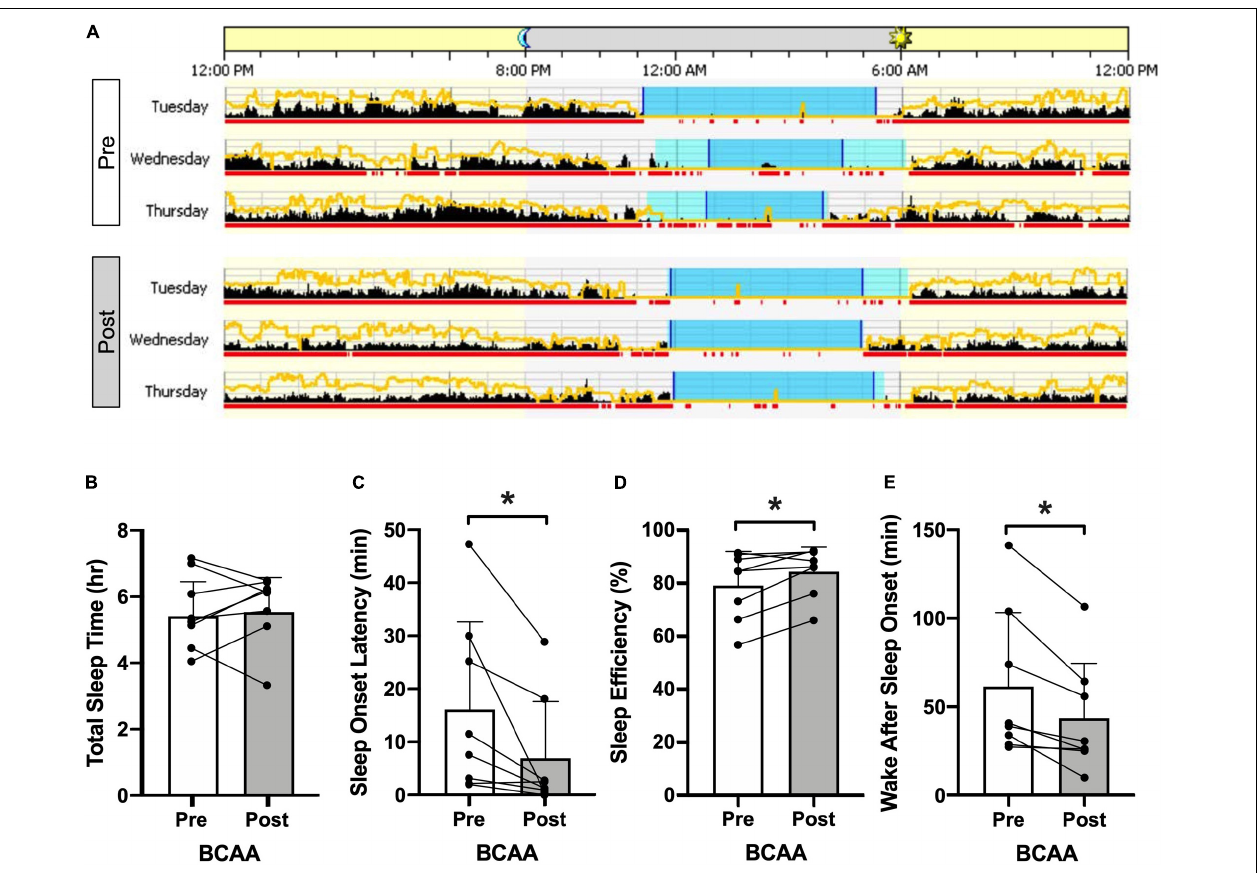
FIGURE 4 | Actigraphy. (A) Representative pre- and post-intervention 3 consecutive mid-week 24-h periods for the BCAA group produced using Philips Actiware. The yellow line represents ambient light exposure and black columns reflect activity counts in 2-min bins. Sleep and wake is differentiated by the red underline (wake) and the blue shaded period indicates the entire “rest interval” with time in bed resting but not asleep) being the light blue intervals and time in bed asleep being the dark blue intervals. Specific actigraphy metrics are plotted in panels (B) total sleep time, (C) sleep onset latency, (D) sleep efficiency, and (E) wake after sleep onset, in the BCAA group with pre- and post-intervention being open and shaded bars (individual data overlaid). * p < 0.05, paired two-tail t -test.